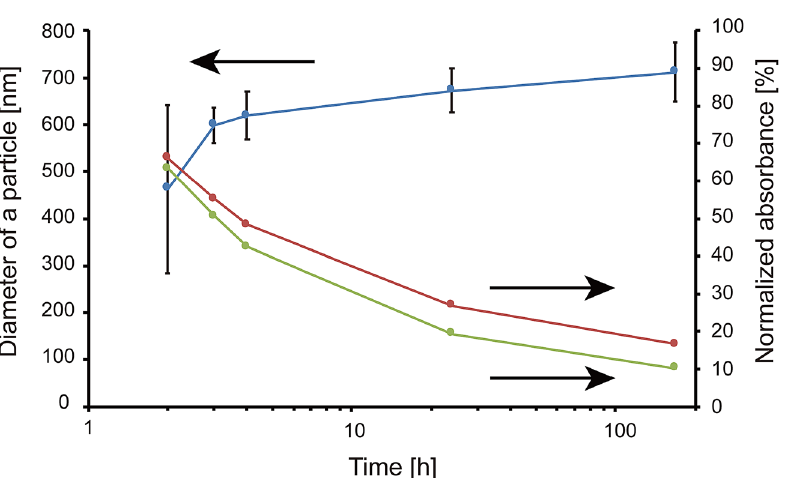
Figure 1. SEM images of particles formed by (6,6)CNBs and C 60 molecules. The particles were synthesized setting the ratio of the molar concentration of (6,6)CNBs to that of C 60 molecules dissolved in 1,2-dichlorobenzene at 1:2 (the concentrations of (6,6)CNBs and C 60 molecules were 0.35 and 0.70 µmol ml −1 ). The scale bars represent 5 µm. ( a ) 3 h after the mixture of the two solutions; ( b ) 4 h; ( c ) 24 h.